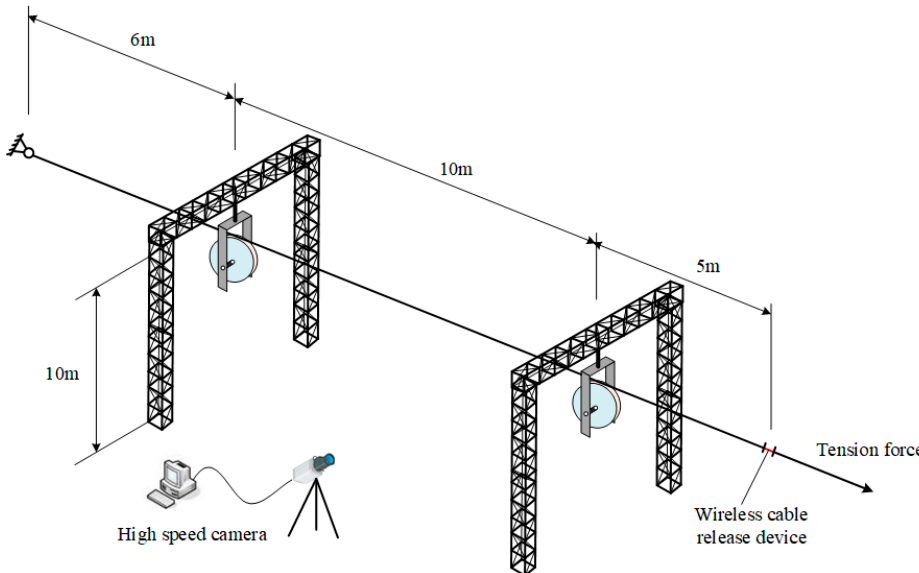
Figure 9. Schematic view of the experimental setting.